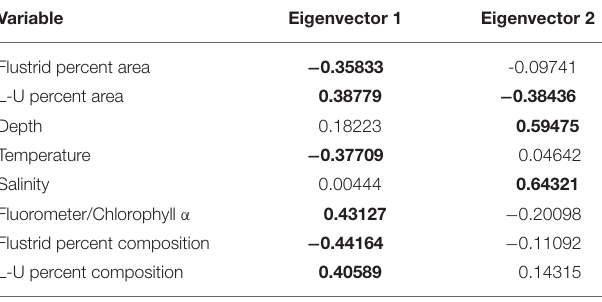
TABLE 3 | Breakdown of the first two eigenvectors resulting from the principle component analysis.